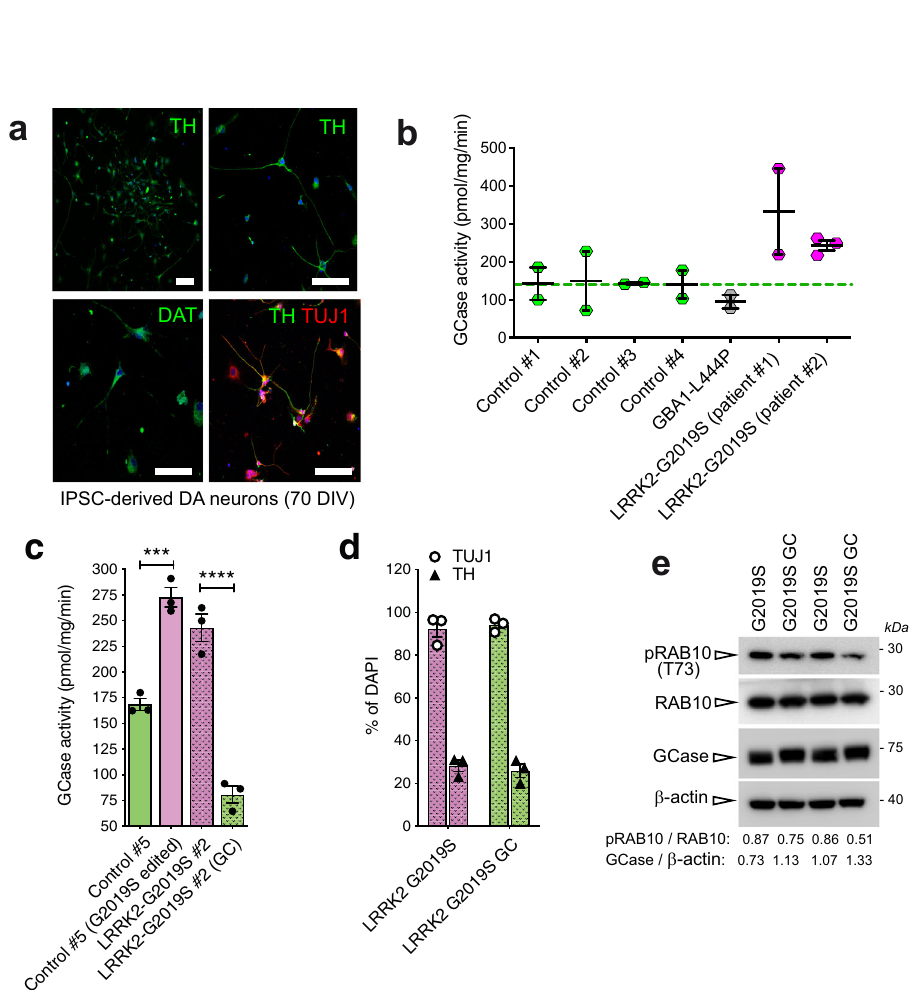
Fig. 4 iPSc-derived neurons from LRRK2 G2019S PD patients and GBA1 PD patient show altered GCase activity compared to neurons derived from healthy subjects. a Representative confocal images of iPSC-derived neurons stained with TH, DAT, and TUJ1 antibodies to verify proper differentiation to dopaminergic cells. b GCase activity measured in iPSC-derived neurons obtained from four healthy controls, one GBA1 L444P PD patients and two LRRK2 G2019S PD patients (2 – 3 replicates per individual). Data show that GBA1 PD patients have a reduced GCase activity compared with controls, while LRRK2 PD patients present increased GCase activity (data are expressed as mean ± SEM). c GCase activity measured in iPSC-derived dopaminergic neurons obtained from one healthy control in which the LRRK2 G2019S was introduced (Control #5 G2019S edited) show an increased enzymatic activity compared with the non-edited neuronal cells (Control #5). Similarly, GCase activity was reduced to a level similar to the Control #5 iPSC-derived neurons in LRRK2 G2019S dopaminergic cells (LRRK2-G2019S #2) upon gene correction (LRRK2-G2019S #2 GC). One-way ANOVA with Tukey ’ s post-test (** p < 0.01; **** p < 0.0001; data are expressed as mean ± SEM). d Ef fi ciency of the differentiation into TH- positive neurons in LRRK2-G2019S #2 and LRRK2-G2019S #2 GC is about 30% of neurons (data are expressed as mean ± SEM). e Western blot showing pRAB10 and GCase levels in LRRK2-G2019S #2 and LRRK2-G2019S #2 GC. GCase level and pRAB10 were expressed as ratio of total RAB10 and β -actin,